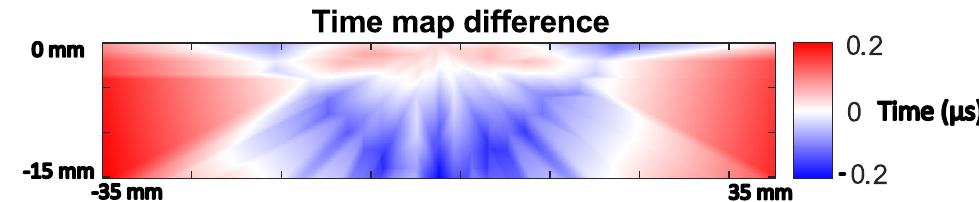
Figure 10. The difference between a travel time map that assumes the constant wave speed of the parent material throughout the domain and one that accounts for the predicted grain map, using centrally placed transducer